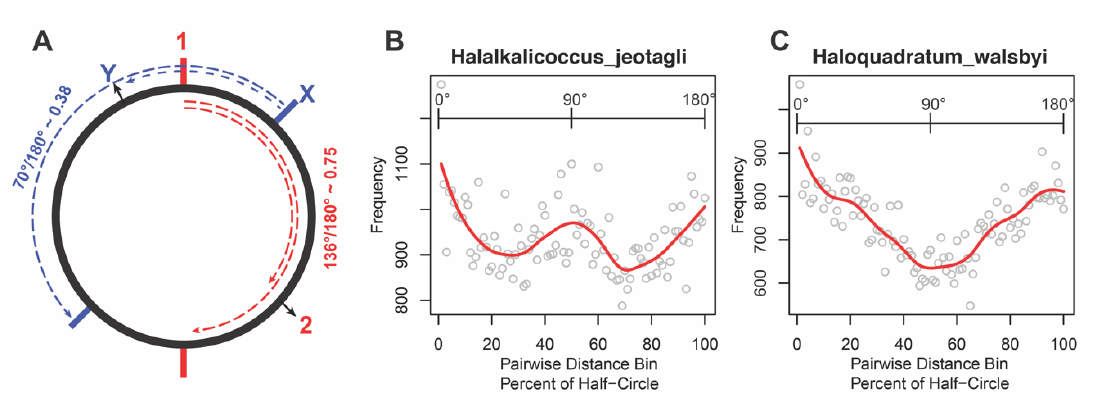
Figure 9. Analysis of relative chromosomal distances for genes in the haloarchaeal OLS context forest. ( A ) A schematic depicting the calculation of chromosomal distance along a relative bisect. The solid circle represents the archaeal chromosome. The relative locations for hypothetical genes 1 and 2 (colored red) are depicted by numbers. Two solid red lines represent points on the chromosome that define the bisect of the chromosome when one end is anchored on the center coordinate of gene 1. One of the dashed red lines represents the distance around half the chromosome starting at the midpoint of gene 1. A second dashed line represents the distance between gene 1 and 2. The fractional angle or distance can be computed as the ratio between the gene-pair distance and the distance around half of the chromosome. A second pair of genes X and Y are labeled blue and depict the calculation of the relative chromosomal distance between these two genes along the bisect defined by starting at the midpoint of gene X. All non-redundant pairwise distances were calculated for genes that were present in the context forest and on the main chromosome. ( B ) The binned distribution of pairwise distances are depicted for genes on the Halalkalicoccus jeotagli chromosome. The red line is a smoothed interpolation through the data. ( C ) The binned distribution of pairwise distances are depicted for genes on the Haloquadratum walsbyi chromosome. The red line is a smoothed interpolation through the data.